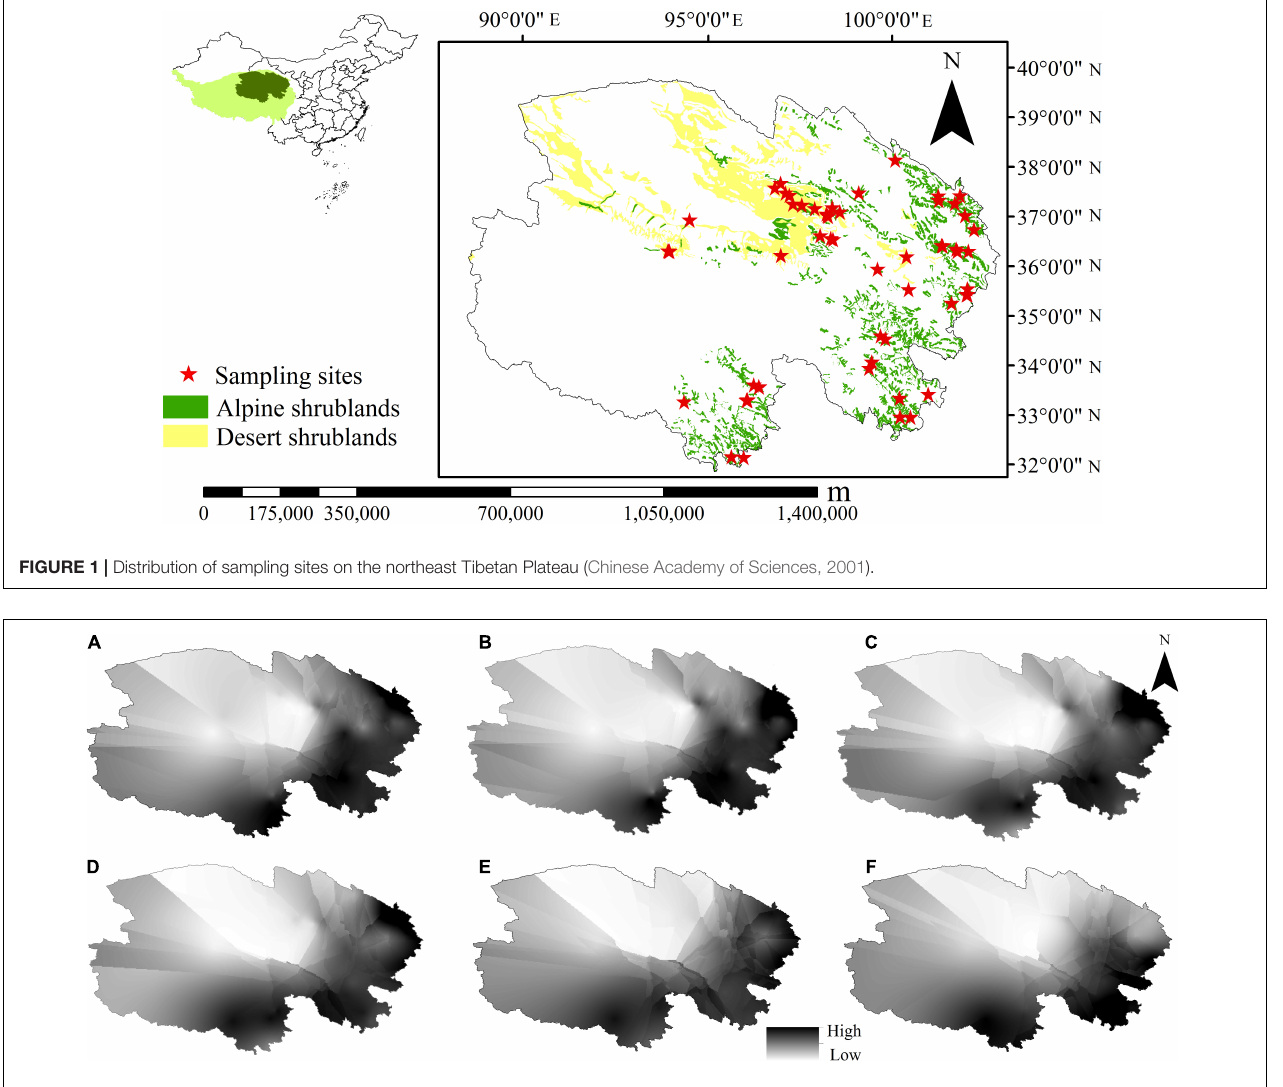
FIGURE 2 | Spatial distribution of soil nitrogen: phosphorus (N:P) ratio in soil depths of 0–10 cm (A) , 10–20 cm (B) , 20–30 cm (C) , 30–50 cm (D) , 50–70 cm (E) , and 70–100 cm (F) in the shrublands on the Tibetan